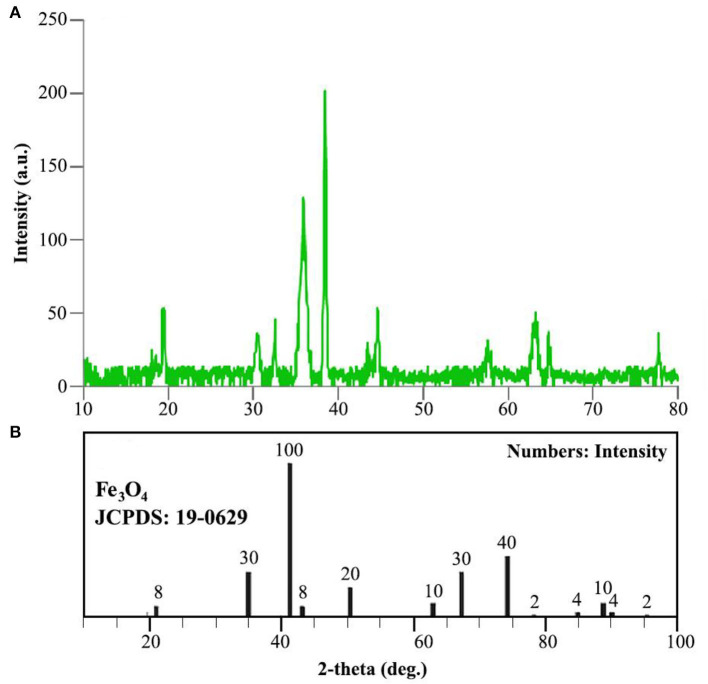
XRD data of Fe3O4@PVA-Cu (A) and Fe3O4 nanoparticles (B).